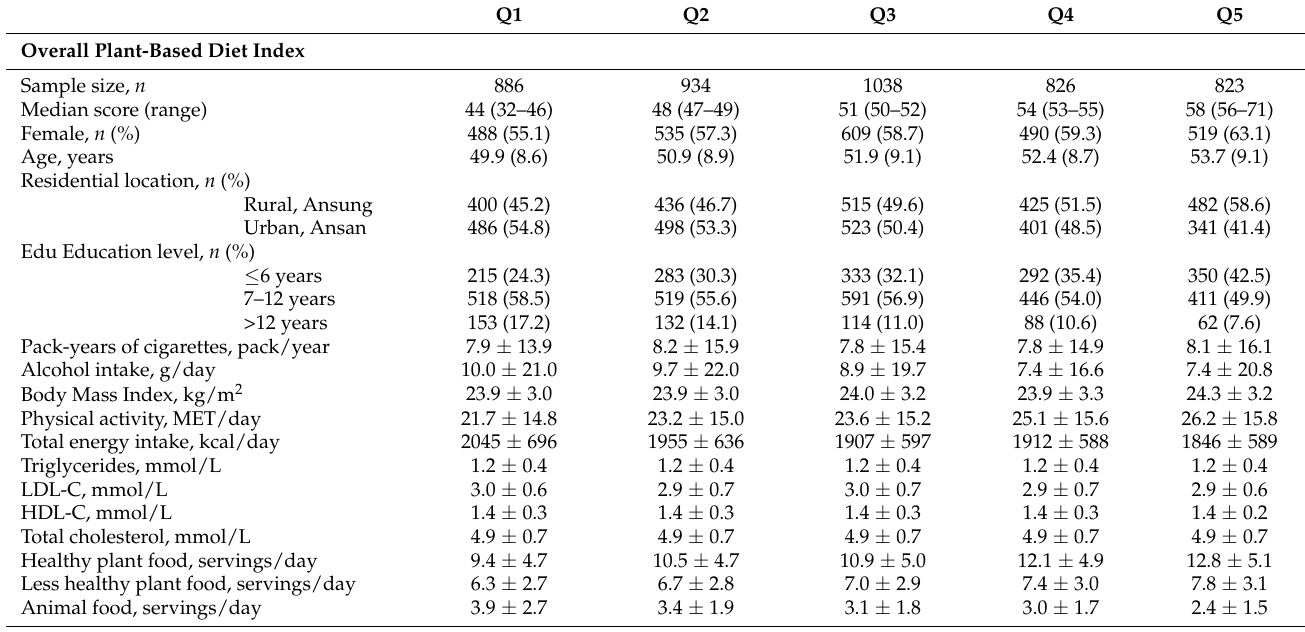
Table 1. Baseline characteristics of study participants according to quintiles of plant-based diet indices in the Korean adults. Q1 Q2 Q3 Q4 Q5 Overall Plant-Based Diet Index Sample size,